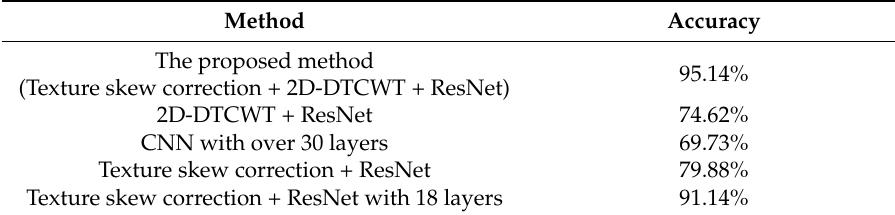
Table 5. Comparisons the